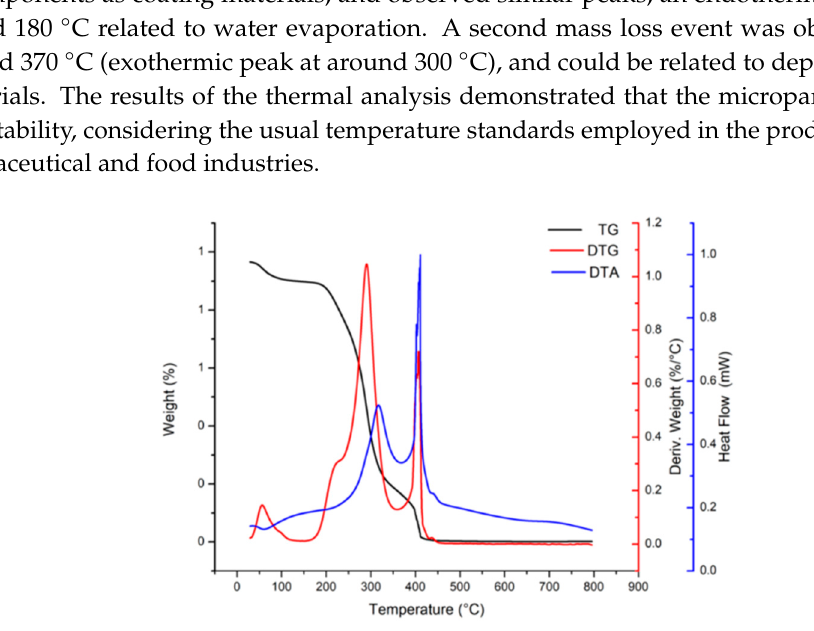
Figure 5. Thermogravimetric (TG) and derived thermogravimetric (DTG) profiles of microparticles.